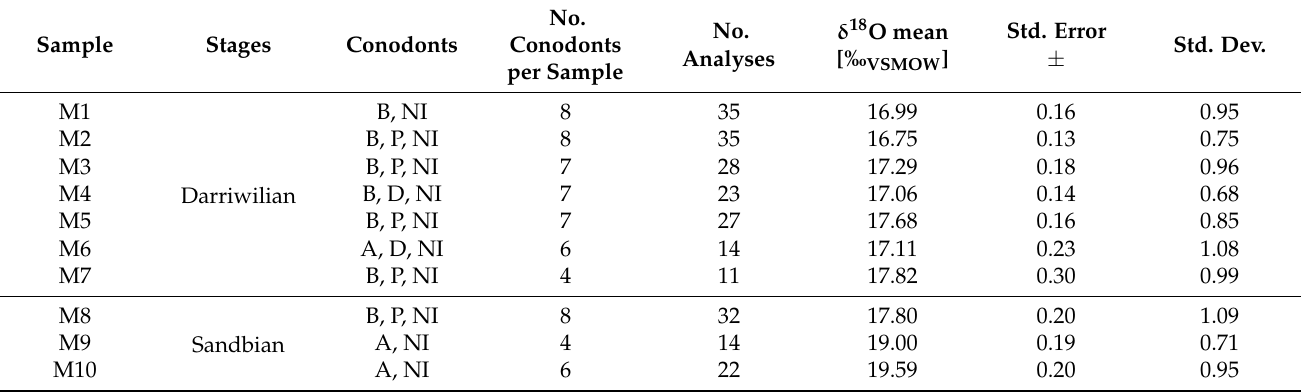
Table 1. Oxygen isotopic results from the Middle and Late Ordovician conodonts of the Mójcza section.